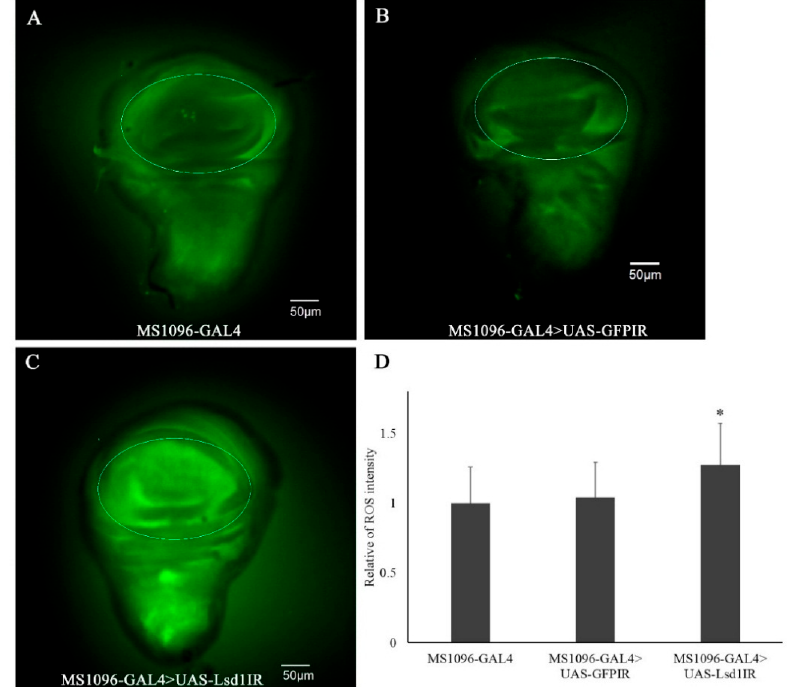
Figure 4. Knockdown of Lsd1 induces ectopic ROS in wing imaginal discs. Wing discs of third-instar larvae were incubated with substrate CM-H 2 DCFDA. The control lines MS1096-GAL4 ( A ) and MS1096-GAL4 > UAS- GFP IR ( B ) showed an unclear ROS signal in the wing disc (marked by the circle), while the Lsd1 -knockdown line (MS1096-GAL4 > UAS- Lsd1 IR) showed an increased ROS signal ( C ); ( D ) Quantification of fluorescent ROS signals in the wing pouch region. Mean intensities with standard deviation from six imaginal discs are shown; * p < 0.05, Student’s t test.